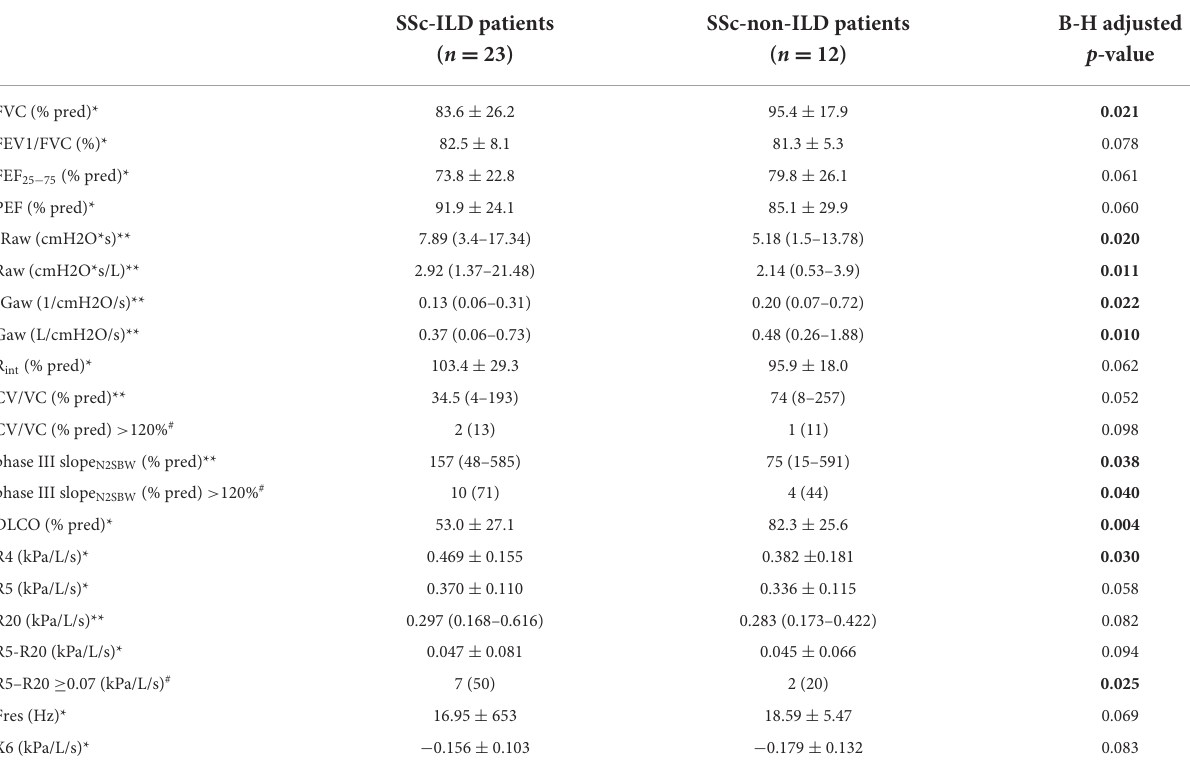
TABLE 4 Comparison of pulmonary and small airway parameters between SSc-ILD and SSc-non-ILD patients.